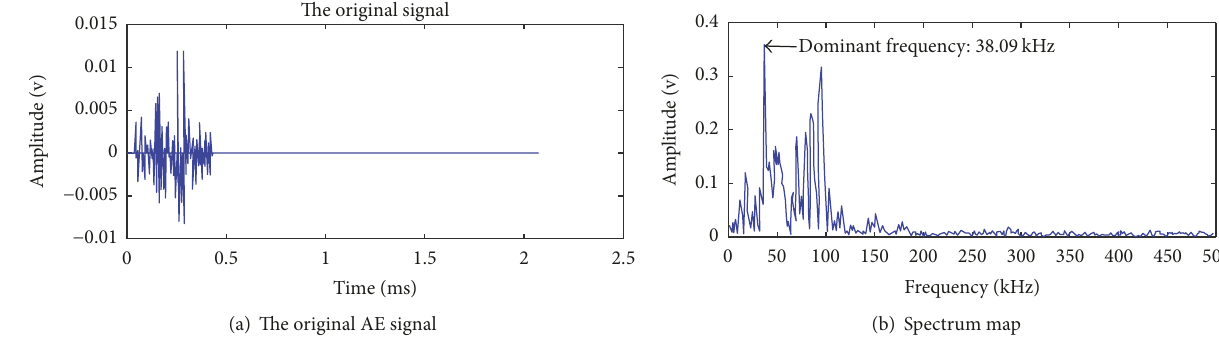
Figure 3: The extraction process of AE dominant-frequency.